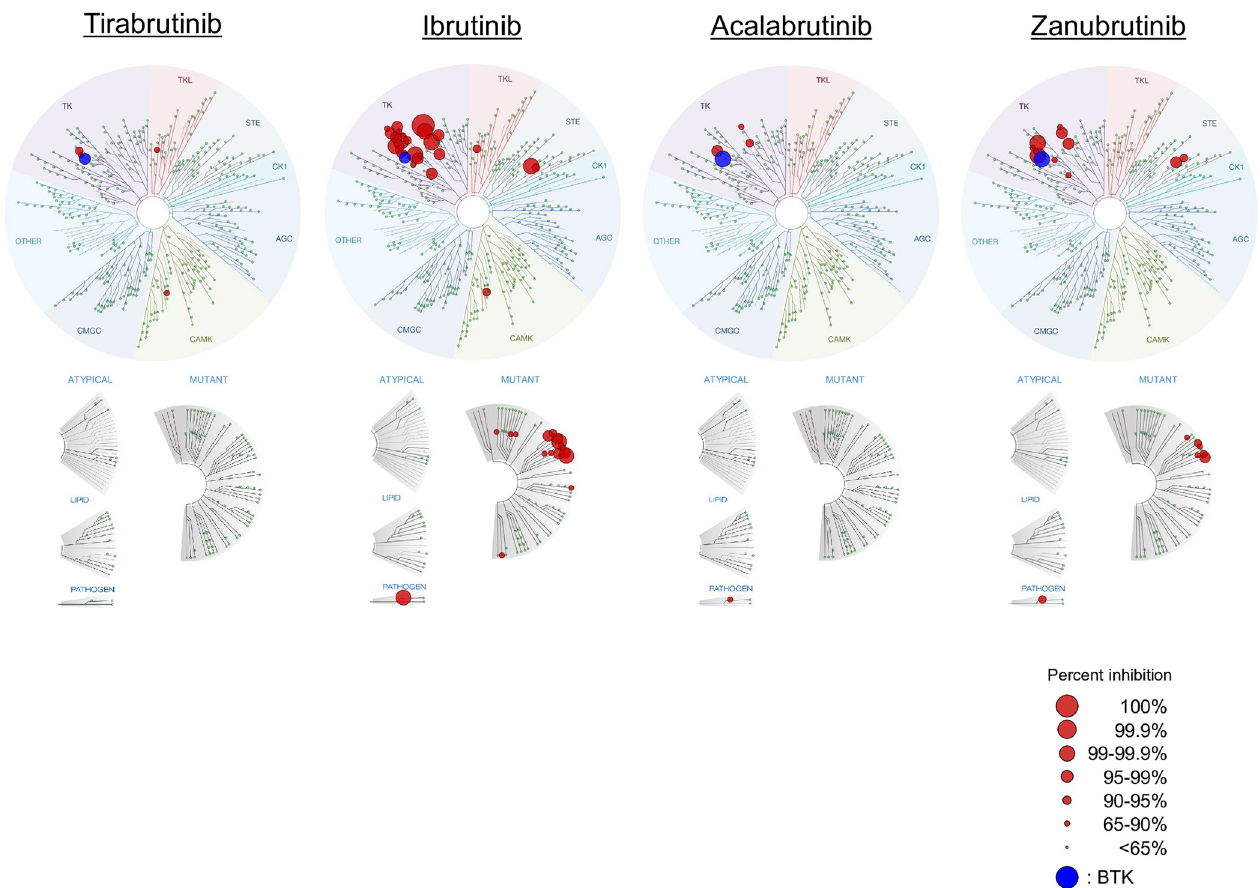
Fig 1. Kinome profiling using the KINOMEscan assay for the first- and second-generation BTK inhibitors. KINOMEscan profile against 442 kinases at 300 nM are shown as a TreeSpot diagram, which depicts all test kinases on a circular dendrogram of the human kinome, with interacting kinases (percent inhibition; > 65%) shown in blue (BTK) or red (kinases other than BTK); non-interacting kinases are represented as small green dots. The images were generated using TREEspot ™ Software Tool and reprinted with permission from KINOMEscan ™ , a division of Eurofins Corporation ( © DISCOVERX CORPORATION 2010). BTK, Bruton’s tyrosine